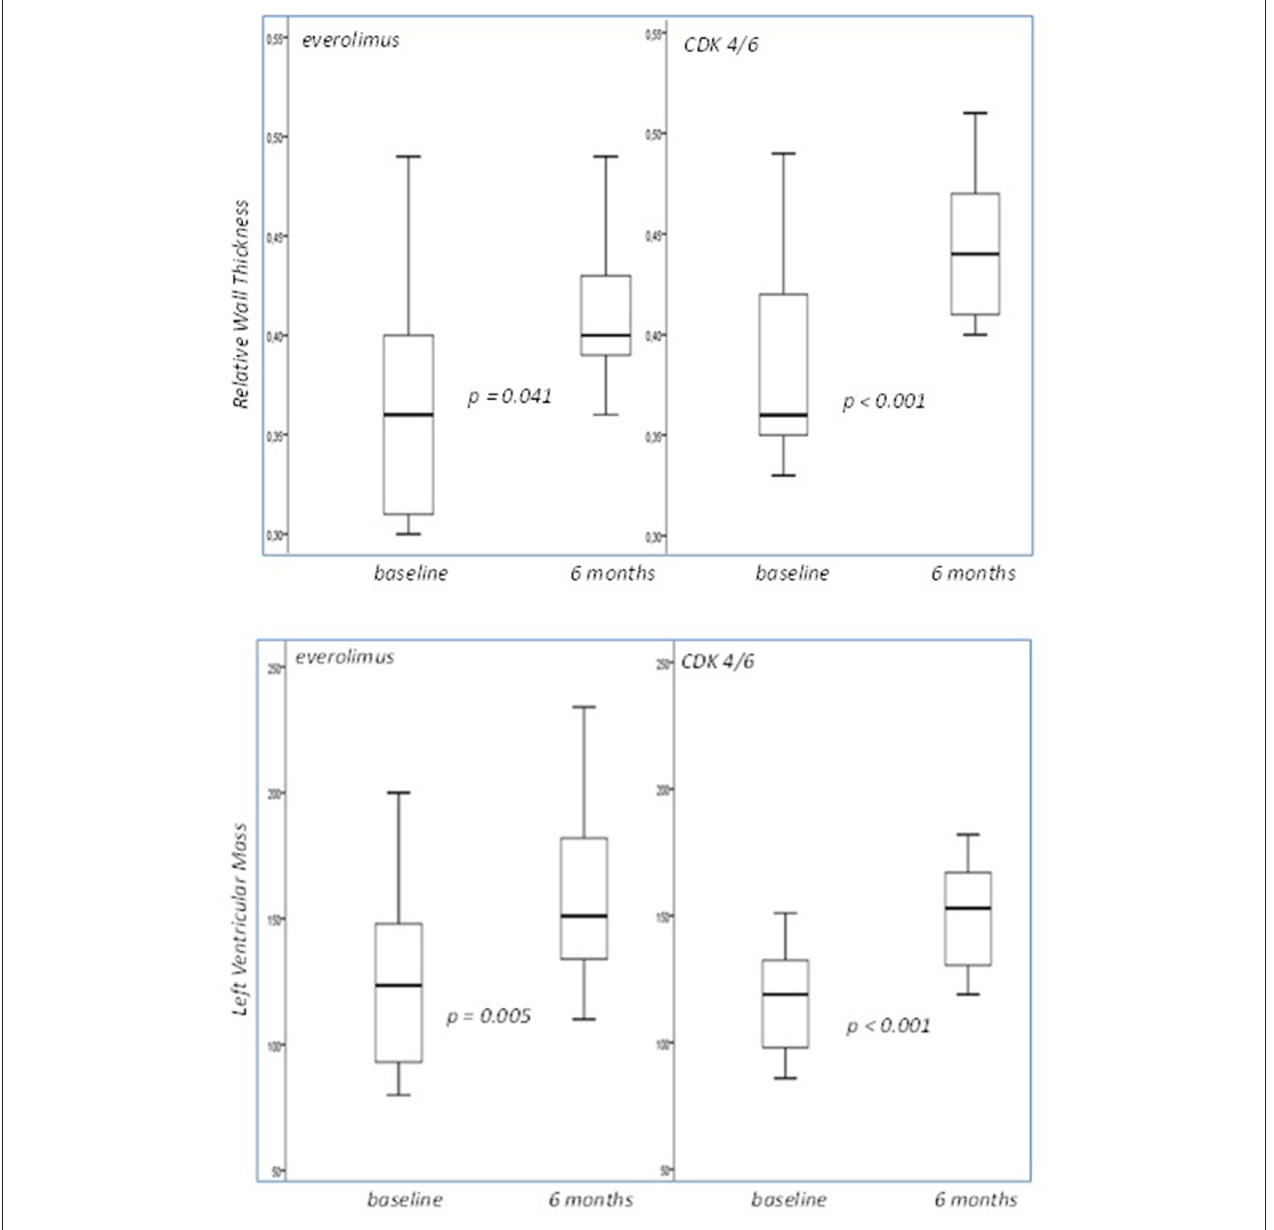
FIGURE 2 | Box plots of the relative wall thickness and left ventricular mass cross-tabulated by different treatment regimens. Both displayed statistically significant damaging effect. LVM was measured in